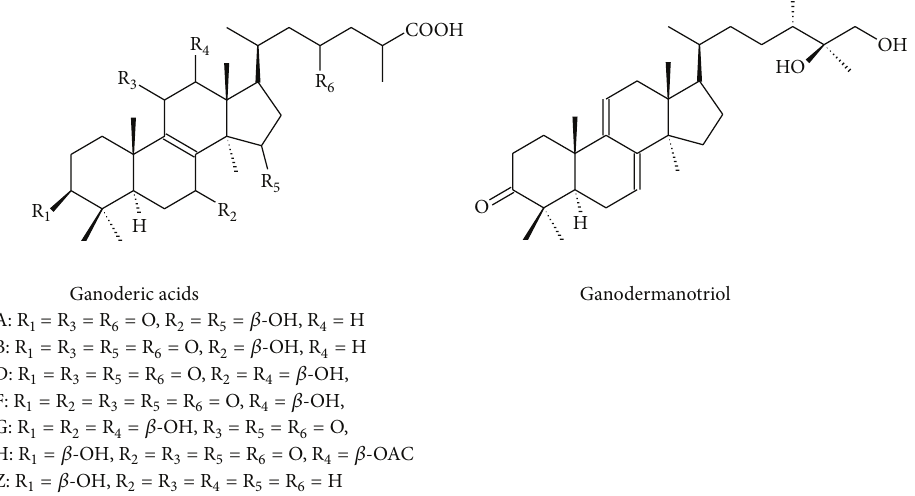
Figure 3: Structures of different ganoderic acids and derivative isolated from G. lucidum .